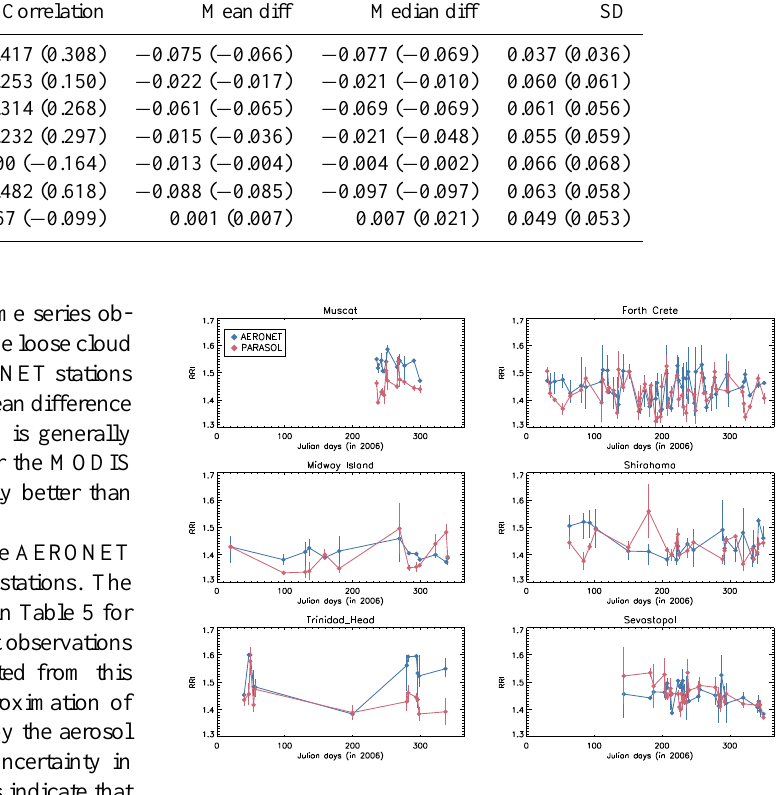
Figure 13. Time series of both the real refractive index (at 670nm) retrieved from AERONET observations and the volume-weighted real refractive index retrieved from the MR PARASOL observa- tions. The goodness-of-fit + cloud screening is applied on the latter set of observations. The error bars for AERONET show the range of all the observations within 12h of the PARASOL overpass and those for PARASOL show the 1 σ retrieval